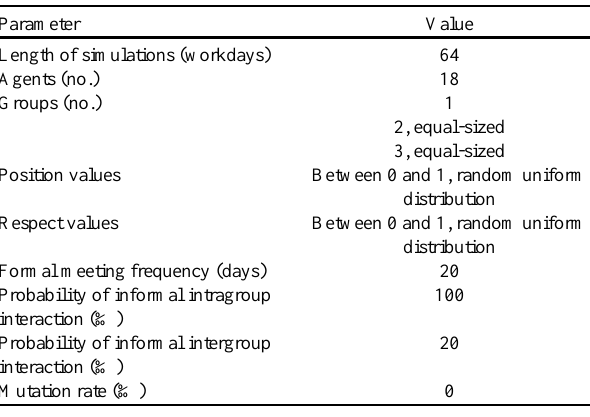
Table 1 . Default parameter values for base model